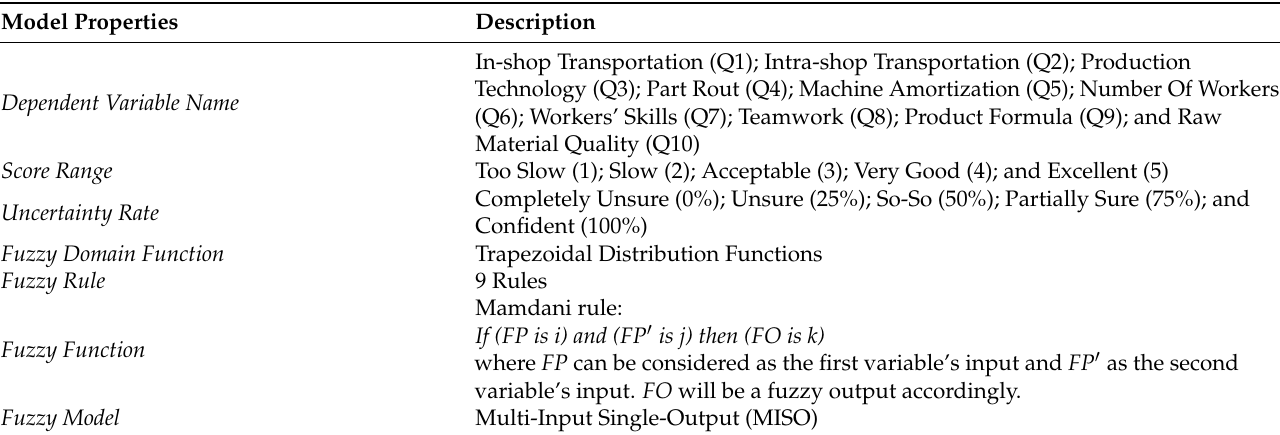
Table 4 indicates the designed FIS model according to the structure explained in Figure 3. Table 4. The FIS Model Description.